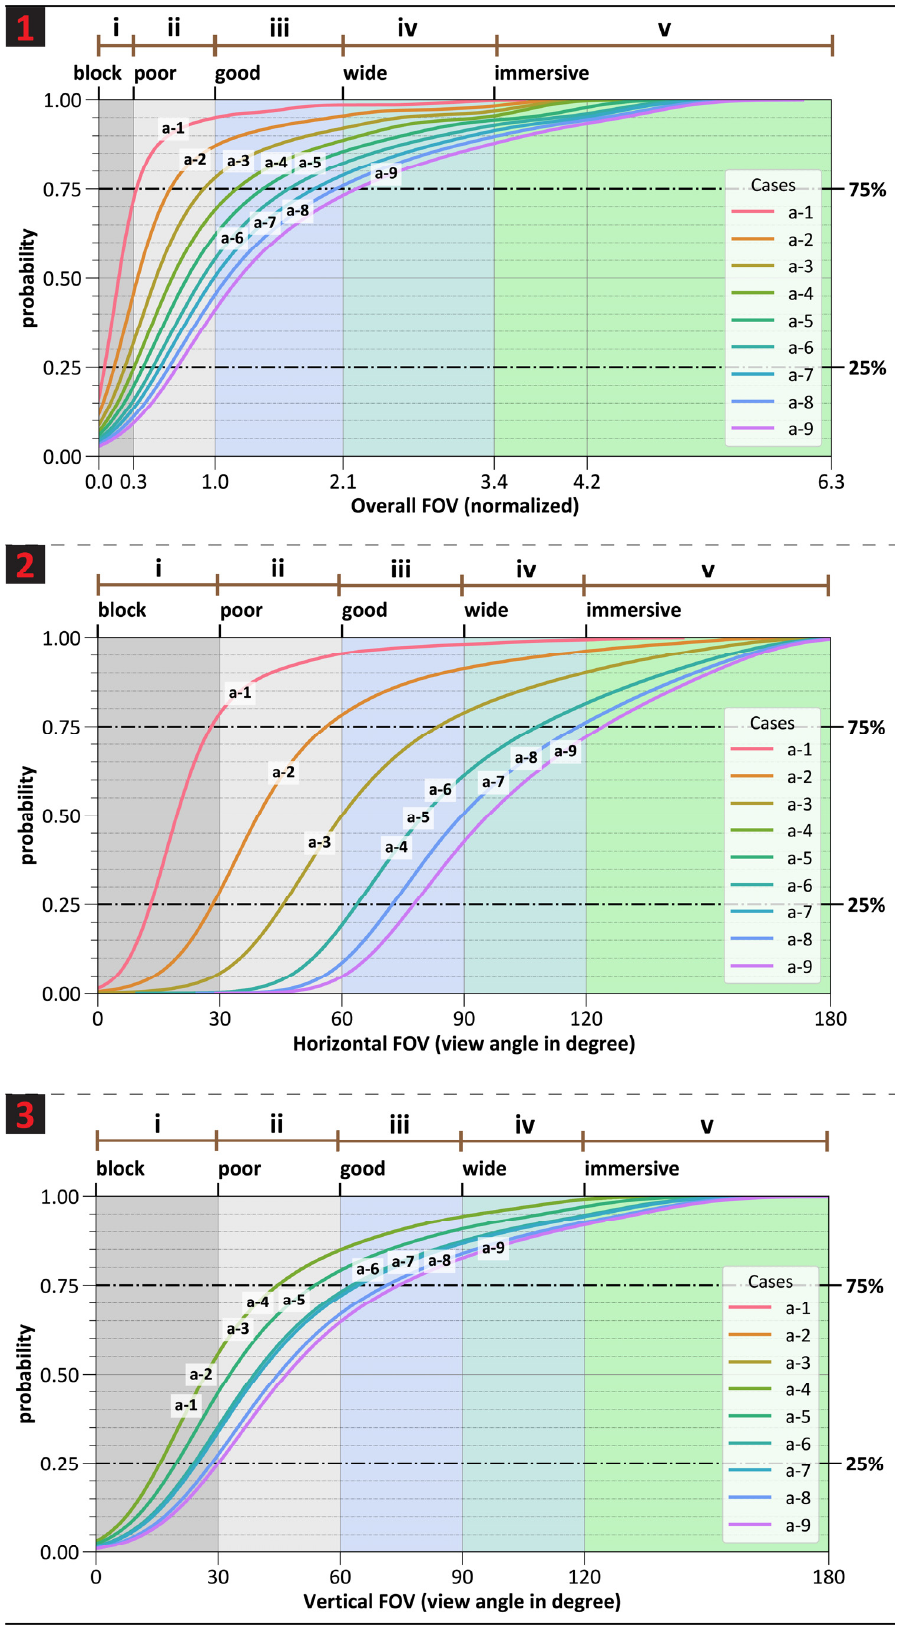
Figure 9. The CDFs of computed overall ( 9-1 ), horizontal ( 9-2 ), and vertical ( 9-3 ) FOVs for scenario-a, including case studies of a-1 to a-9 with different window sizes.